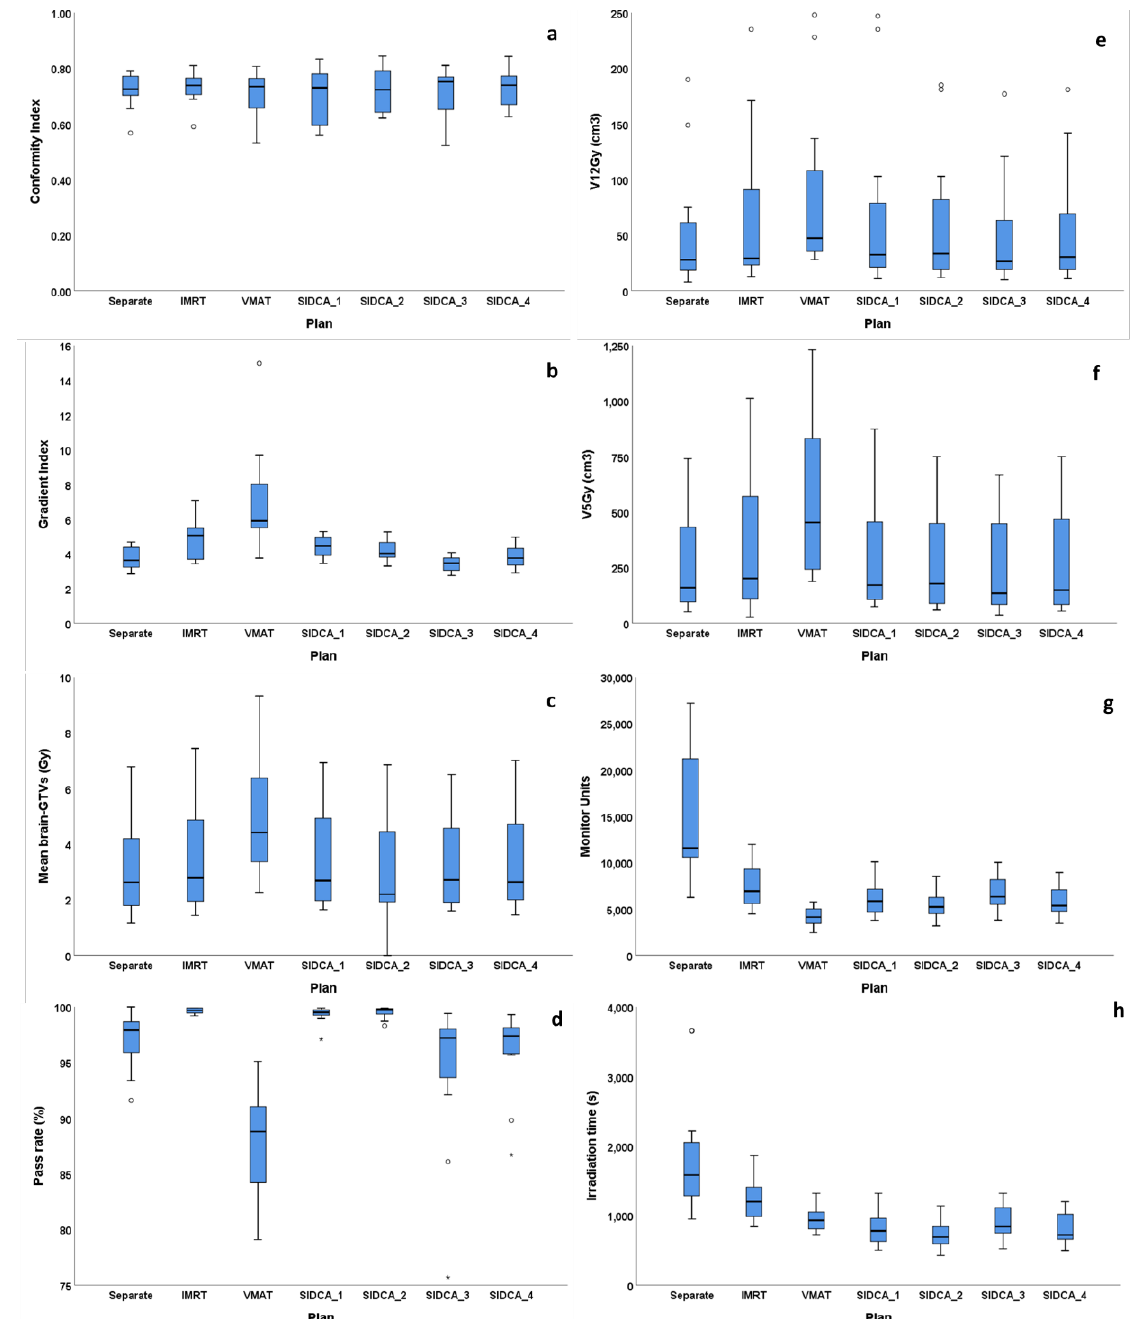
Figure 2. Comparison of the crucial parameters for different patients and planning techniques. Diagrams of the CI ( a ), the GI ( b ), the mean dose ( c ), the total V 12Gy ( d ) and V 5Gy ( e ) of the uninvolved brain, the number of MUs ( f ), irradiation time ( g ), and pass rate (3%/3 mm) ( h ) for separate-isocenter DCA (separate), IMRT, VMAT, MBM Elements v.1.6 with three couch angles (SIDCA_1), MBM Elements v.1.6 with five couch angles (SIDCA_2), MBM Elements v.2.0 with high NT (SIDCA_3), and low NT (SIDCA_4) plans for 12 patients and the mean values over these patients.